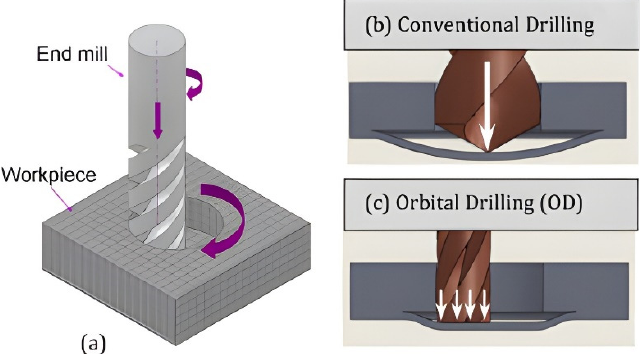
Figure 18. ( a ) Illustration of orbital drilling; deflection of the last ply in ( b ) CD and ( c ) OD [196]. Wang et al. [136] proposed to evaluate the hole quality of CFRP/AA2024-T3 stacks (6/6 mm thick) drilled by the OD process using an 8 mm diameter solid nano-copper- coated carbide three-fluted milling tool with a 45° helix angle, 20° clearance angle and 9° rake angle. A two-step strategy was employed to reduce push-down delamination. It consisted of drilling, from CFRP to AA2024-T3, the first hole with a diameter smaller than the required diameter. Then, the second hole was drilled with the target diameter by reversing the stacking sequence. The results from this drilling process were compared to those obtained by CD using two different diameters of TiAlN-coated solid carbide twist drills with a 140° point angle and 30° helix angle. The first step was performed with a diameter of 8 mm, while the second step was carried out with a diameter of 10 mm. The influence of spindle speed (1000, 2000 and 3000 rpm) and feed speed (5, 10 and 15 mm/min) on thrust force and the delamination factor was also analyzed for both drilling processes. It